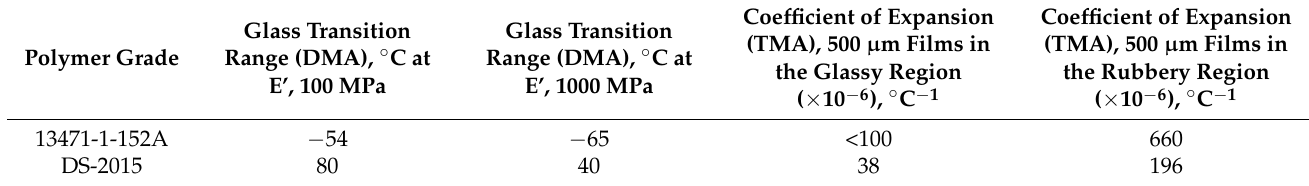
Table 1. CTE of DeSolite polymers, according to the manufacturer [14,15].